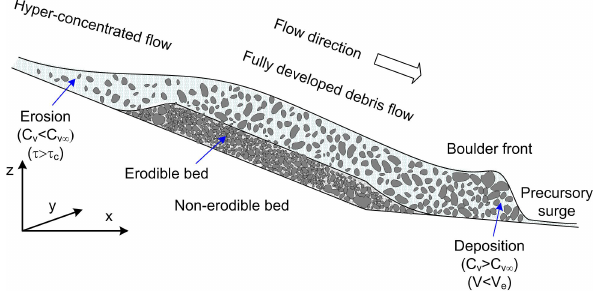
Figure 1. Erosion, deposition and property changes in debris flow.